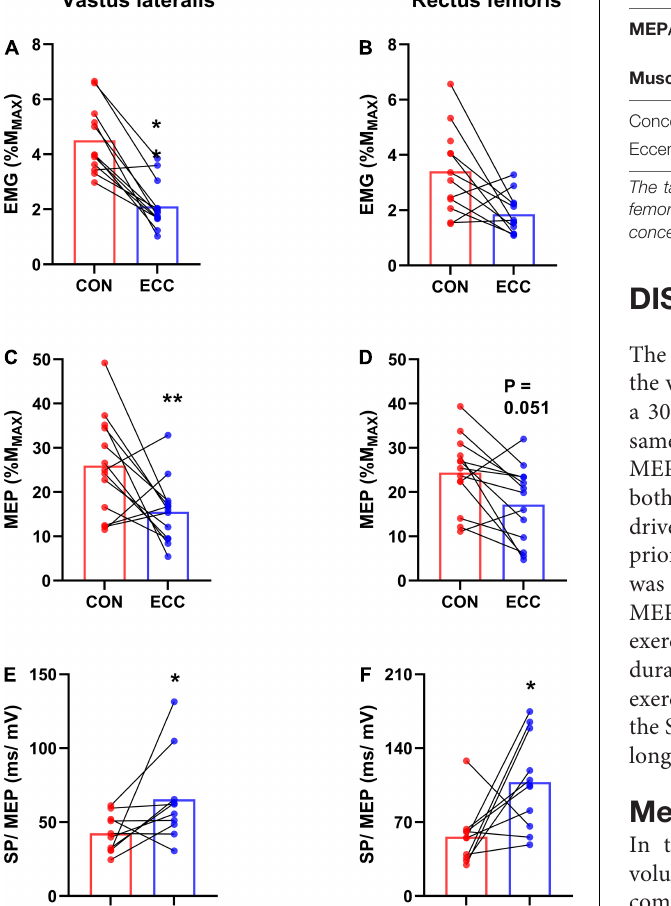
TABLE 2 | Corticospinal excitability normalized to neural